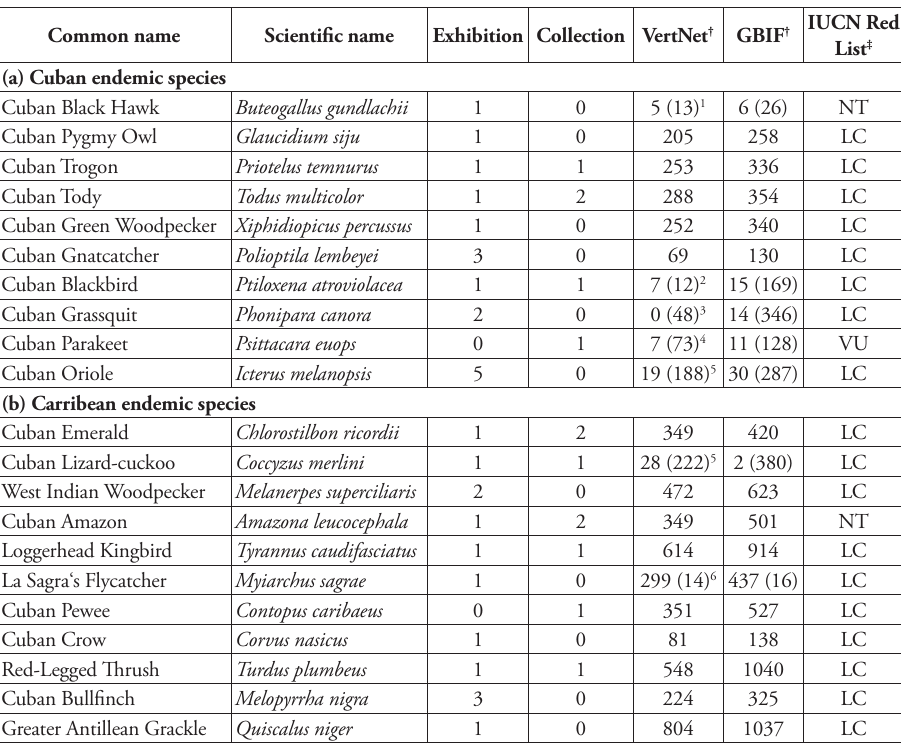
Table 1. Bird species endemic to (a) Cuba and (b) the Caribbean region hold by the Šaris Museum in Bardejov, Slovakia, including number of specimens in public exhibition and the scientific collection and their conservation status according to the IUCN Red List. From online biodiversity databases, VertNet and GBIF, we obtained information on numbers each species deposited in other natural history collec- tions